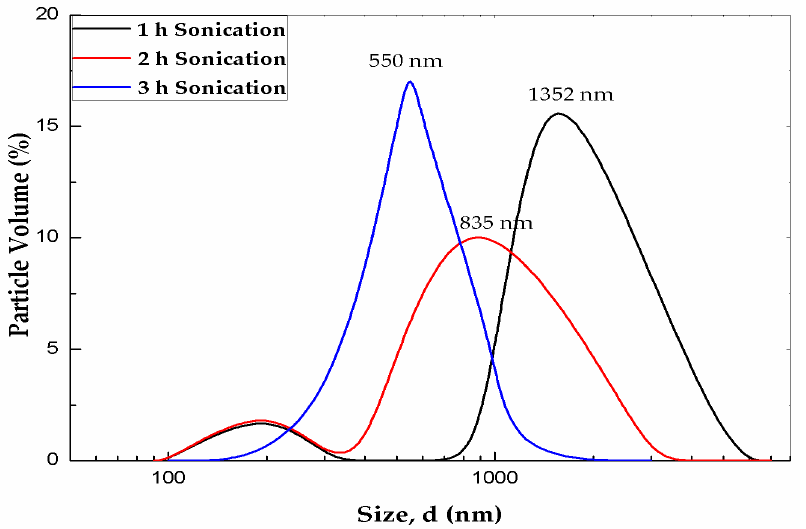
Figure 9. Size distribution of 1.5 vol% ZnO nanofluid dispersed in 40:60 PG/W at different ultrasonication time: 1 h, 2 h, and 3 h. In all measurements, the polydispersity index is 0.4.